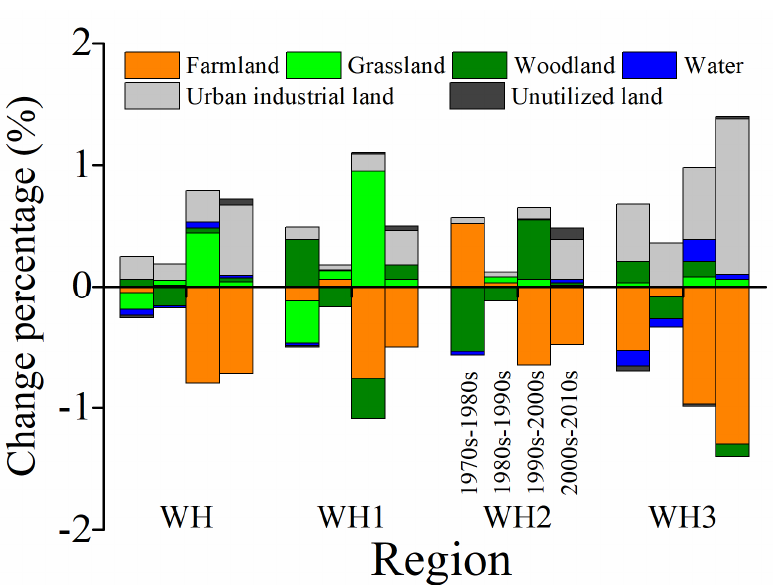
Figure 5. Change percentage of six land use / cover types over the Weihe River basin and the three sub-regions for each decade during the last 50 years.